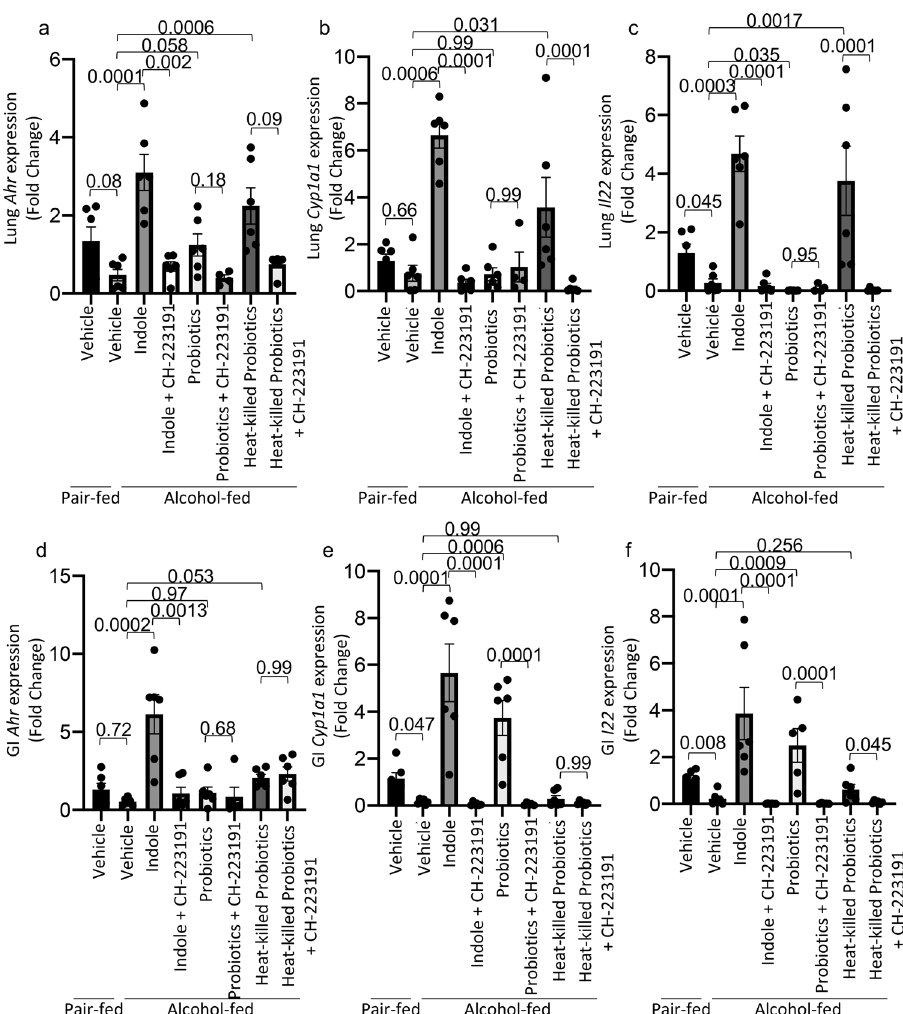
Fig. 6 Indole and probiotics treatment increase the expression of AhR dependent genes. Binge-on-chronic alcohol-fed mice with and without treatment were infected with Klebsiella and sacri fi ced after 48 h of infection. Pulmonary expression (fold change) of a Ahr, b Cyp1a1, and c Il22 in binge-on-chronic alcohol-fed mice with and without treatment infected with Klebsiella . Small intestinal expression (fold change) of d Ahr, e Cyp1a1, and f Il22 in binge-on- chronic alcohol-fed mice with and without treatment infected with Klebsiella . The qPCR value was normalized to GAPDH, and gene expression levels are shown relative to those of control mice. Bars represent the mean ± SEM and dots represent individual mice. P values are indicated in the fi gure and were determined by one ‐ way ANOVA with Sidak ’ s multiple comparison test based off of delta delta CT values. N =